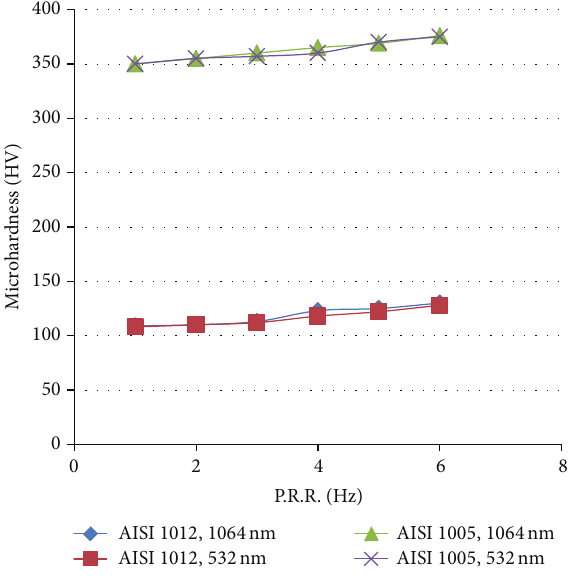
Figure 9: Variation of microhardness as a function of PRR at 𝑃 𝑝 40 MW.